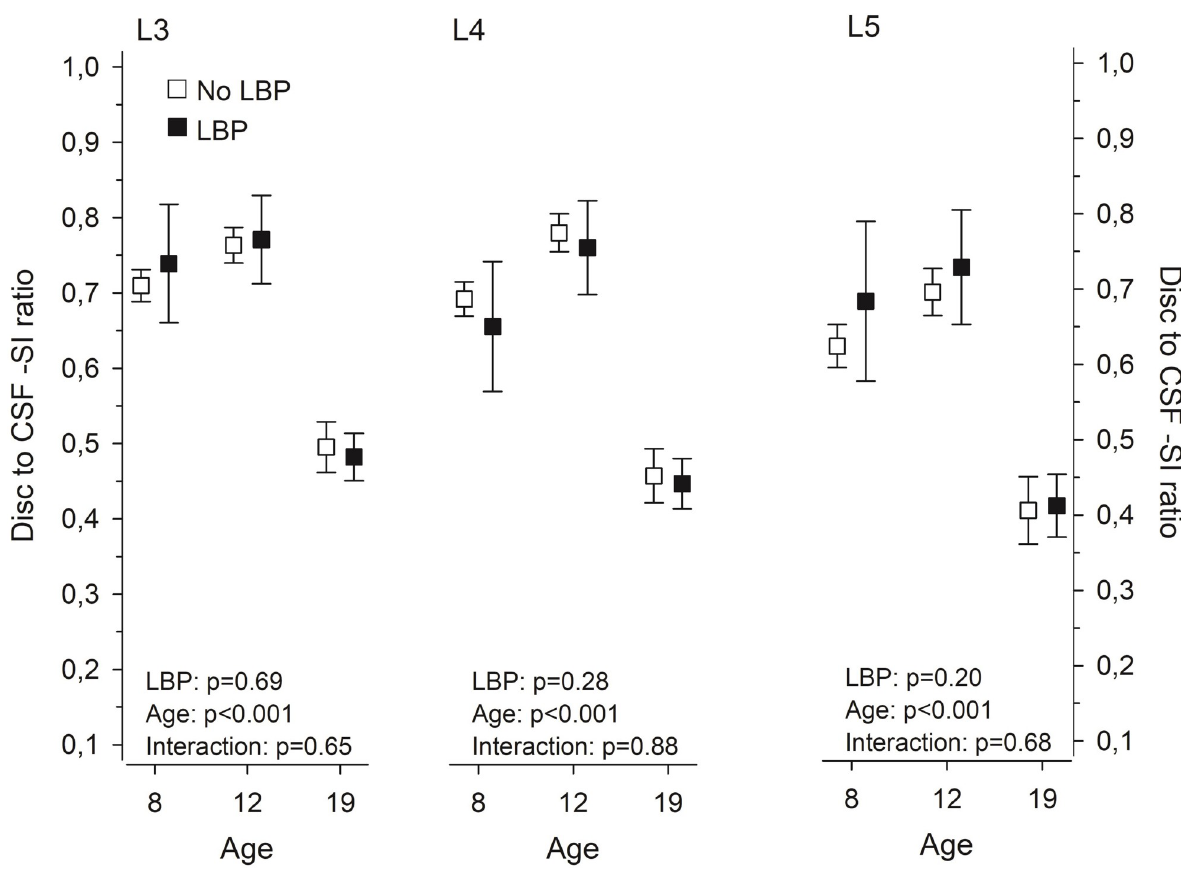
Fig 3. Computerized measurement of the disc signal intensity (SI) to cerebrospinal fluid SI–ratio at 8, 12, and 19 years in subjects with or without LBP. Means with whiskers representing 95 per cent confidence intervals.